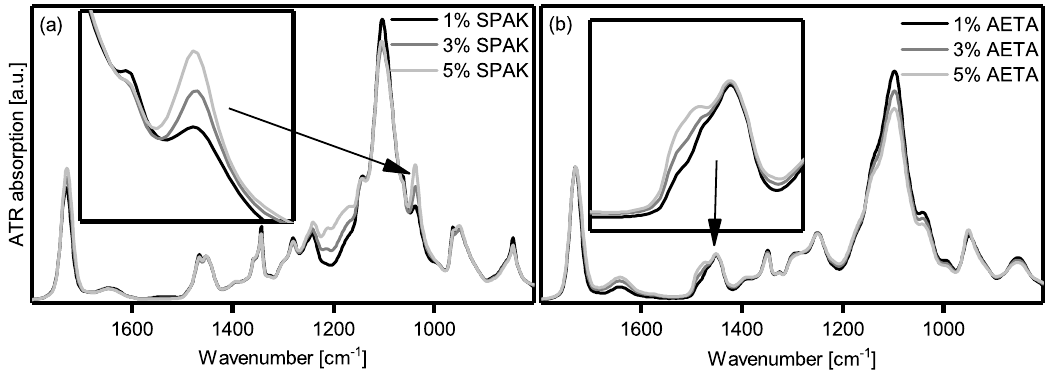
Figure 4. ATR-FT-IR spectra of hydrogels containing 22.5% Poloxamer 407 and different amounts of ( a ) SPAK and ( b ) AETA, respectively. The insets show the respective characteristic absorption bands for the charged